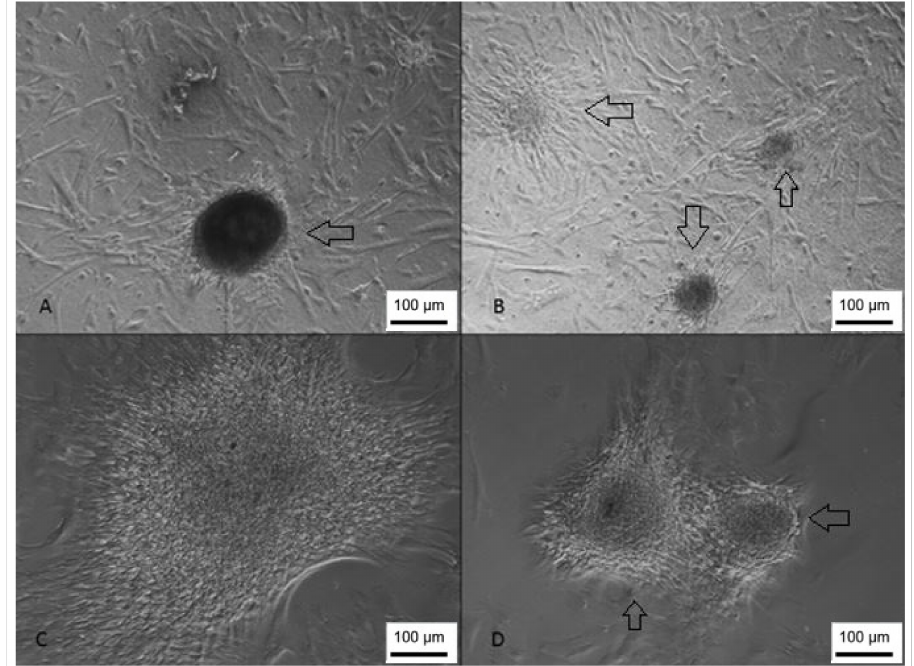
Figure 5. Formation of UCB-MSC-derived neurospheres. ( A , B ) Neurospheres visualized at 100 X magnification; ( C , D ) neurospheres visualized at 200 X magnification (inverted optical microscopy. Scale bar, 100 µ